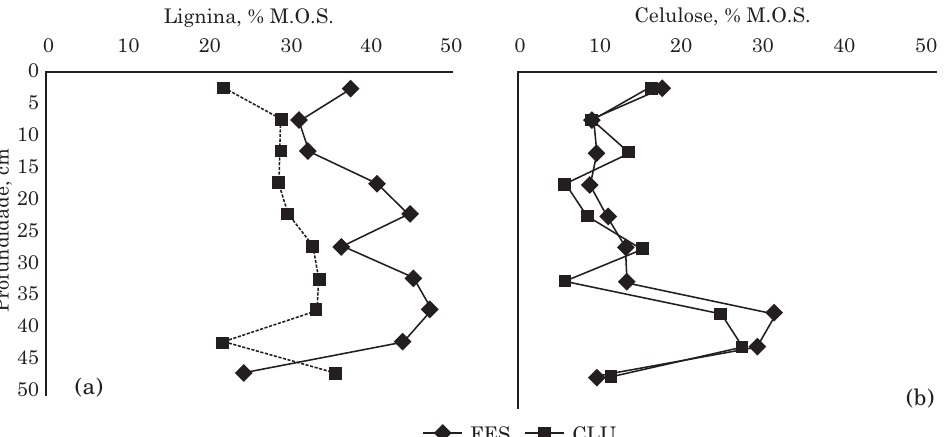
Figura 3. Teor médio de (a) lignina e (b) celulose (% MOS) em profundidade no Campo Limpo Úmido (CLU) e na Floresta Estacional Semidecidual